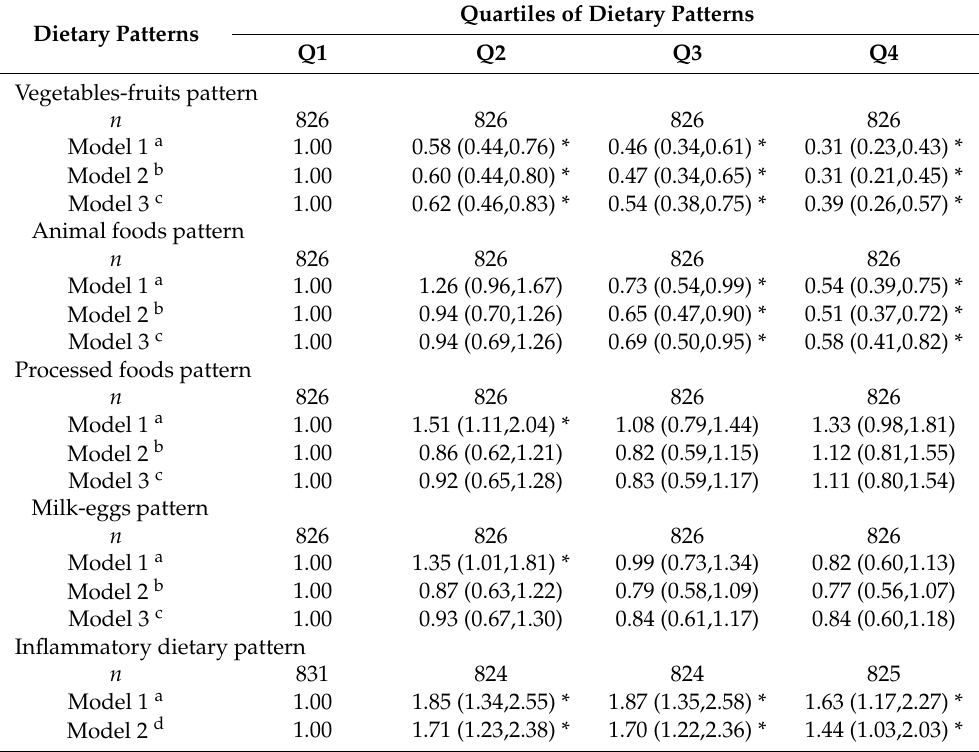
Table 5. Associations between each dietary pattern quartiles and depression [ OR (95%